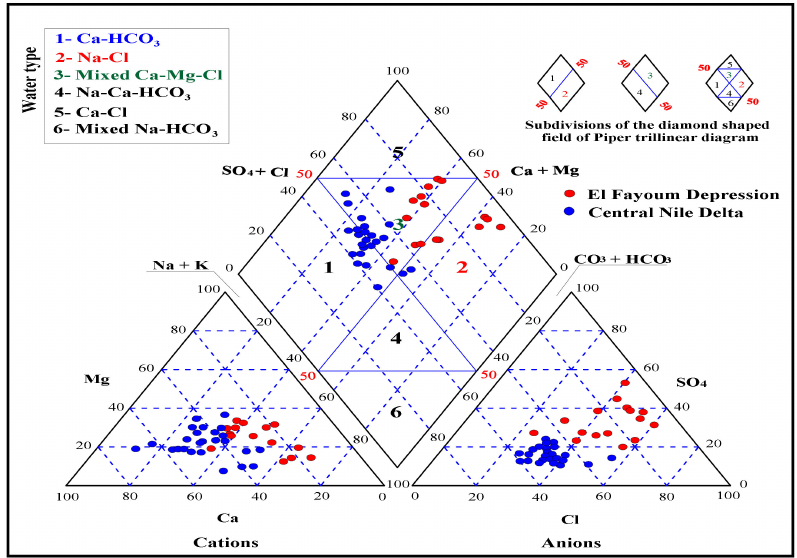
Figure 2. Hydrochemical facies of groundwater samples in the Western Desert and Central Nile Delta based on Piper’s tri-linear diagram.